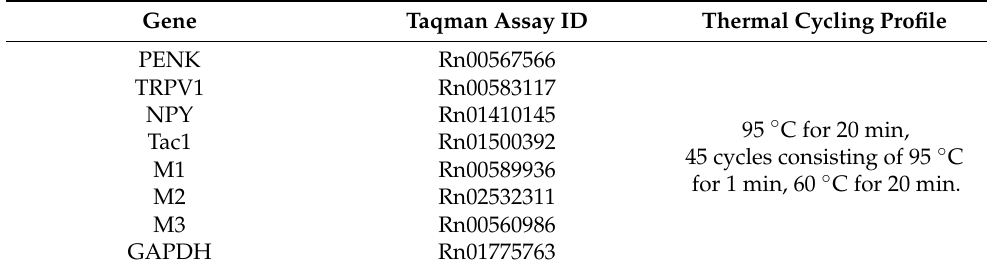
Table 3. TaqMan ® Gene Expression Assays and thermal cycling profile used for real-time PCR